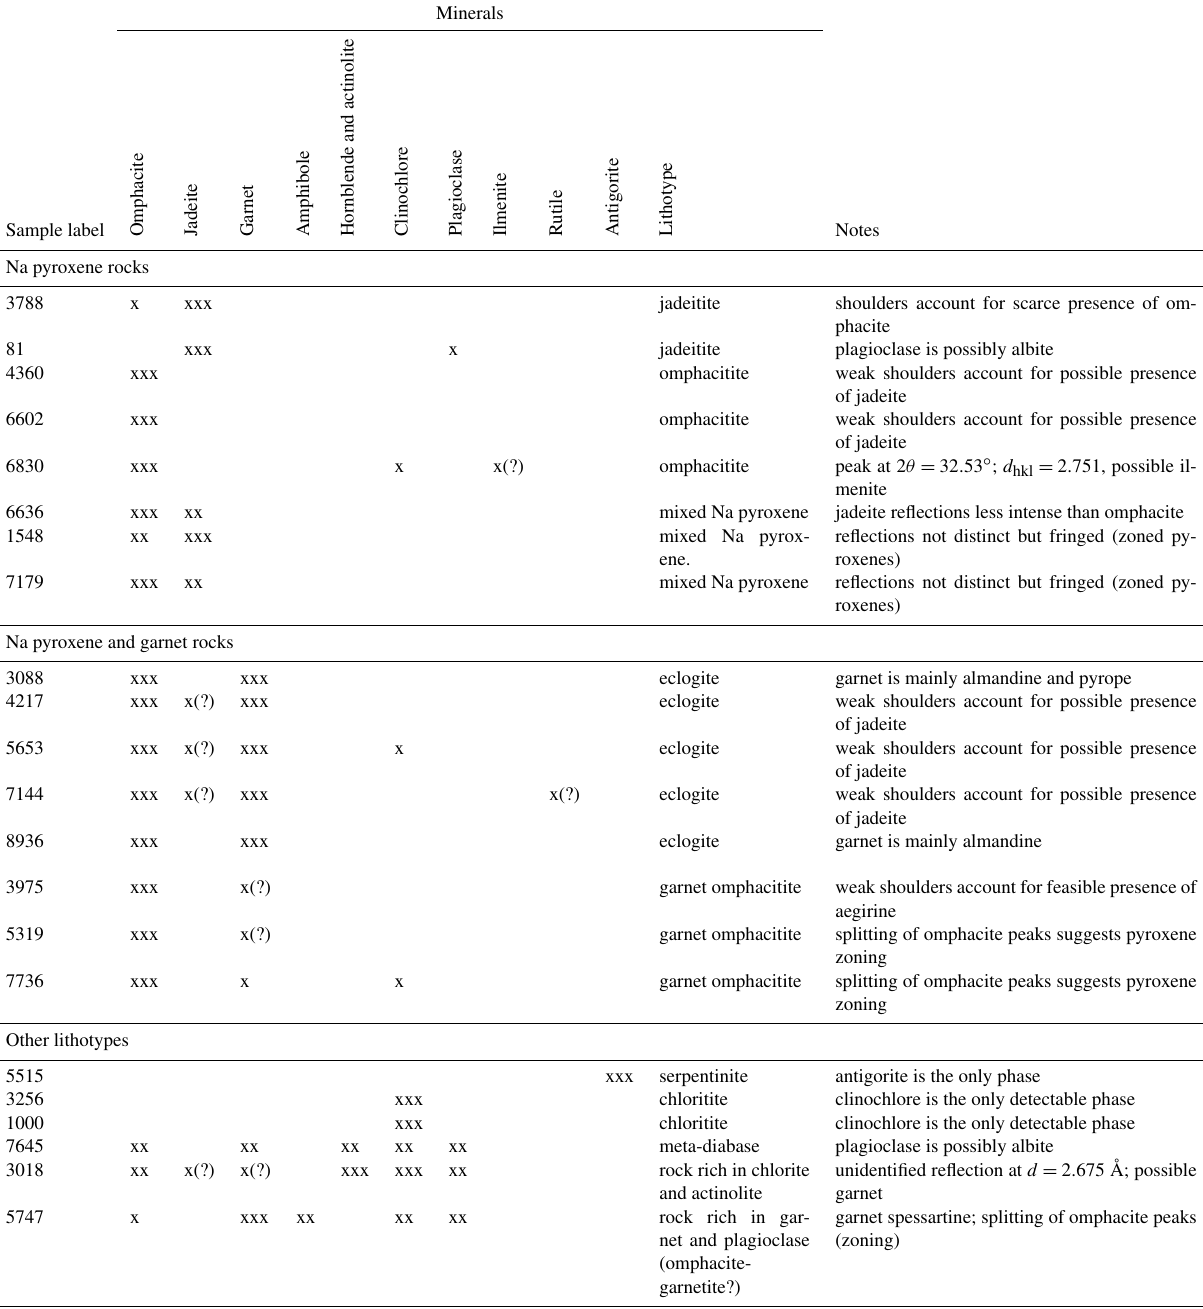
Table 2. Mineralogical composition of the 22 polished stone implements (Na pyroxene rocks, Na pyroxene and garnet rocks, and other lithotypes) from the Neolithic site of Chiomonte, La Maddalena, according to XRPD (XXX: very strong reflections; XX: strong reflections; X: weak reflections; X(?): dubious).